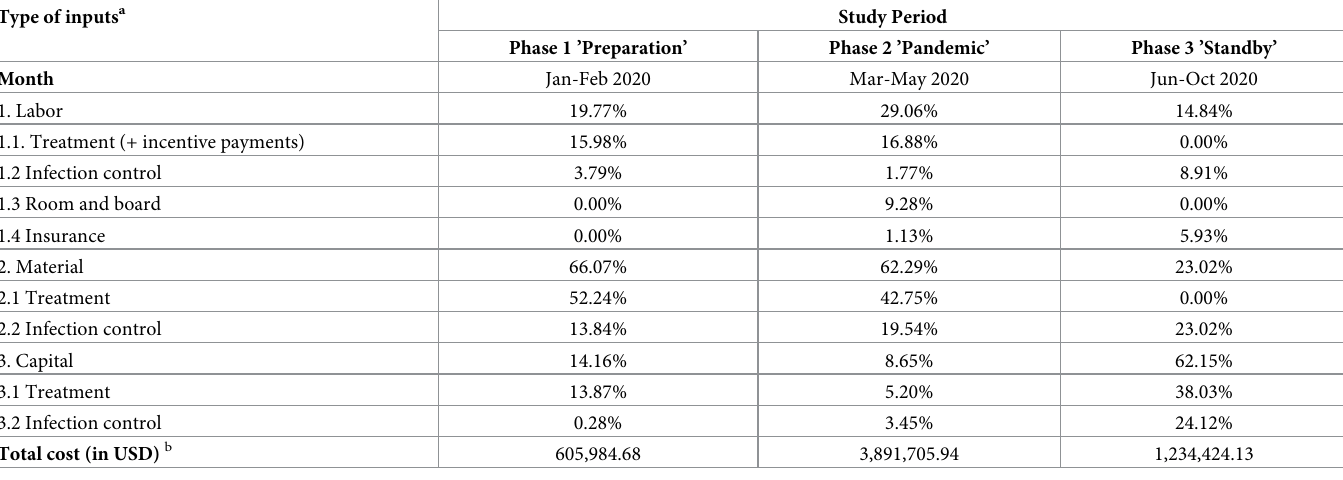
Table 3. Breakdown of cost by type of